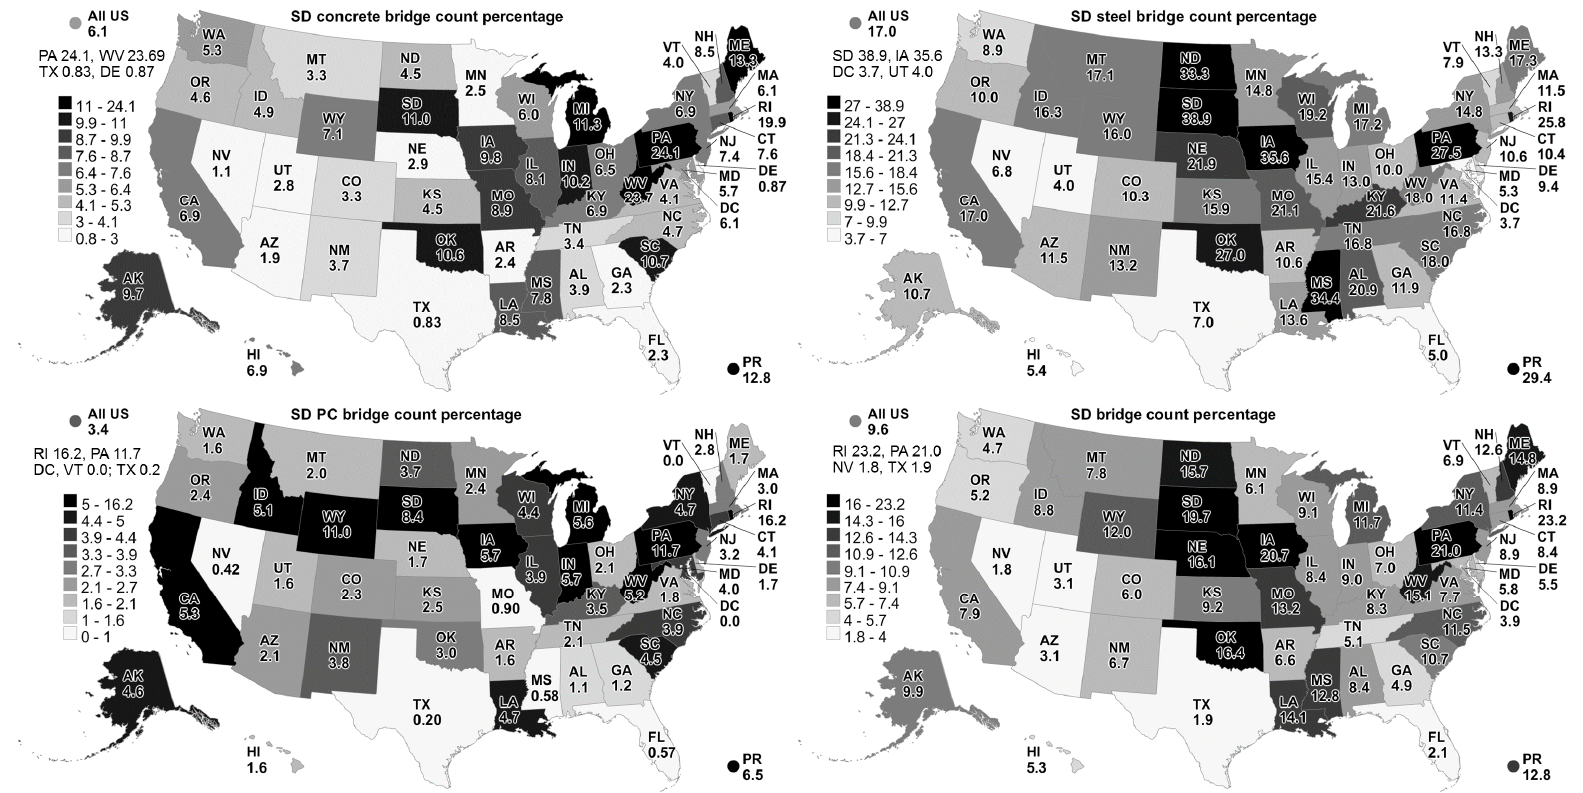
Figure 3. Structurally deficient bridge count percentage from state total.